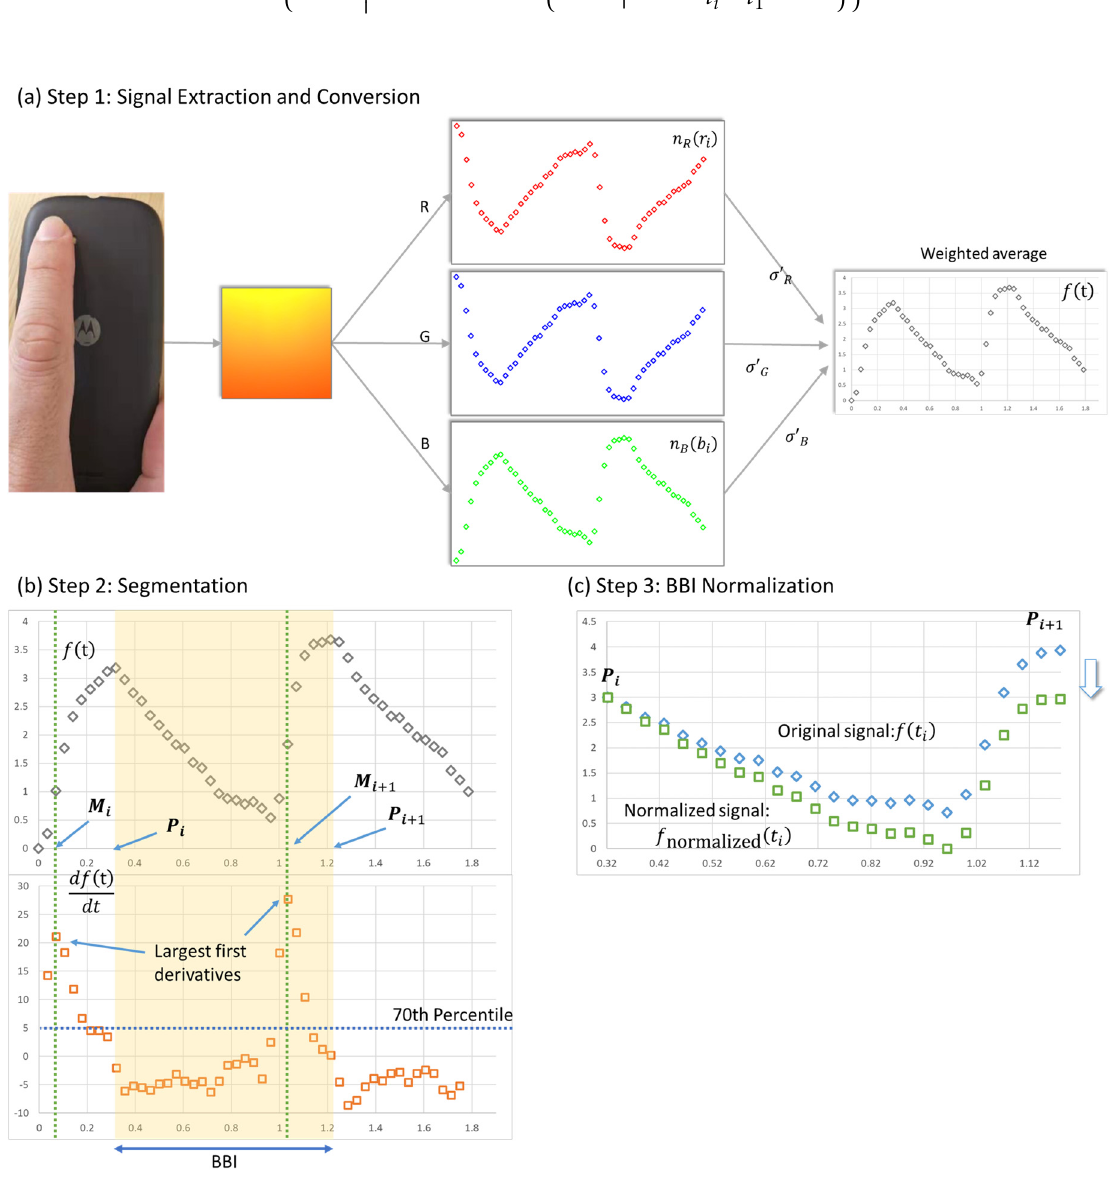
Figure 1. Steps taken to convert raw signals to segmented and normalized pulse waveform.